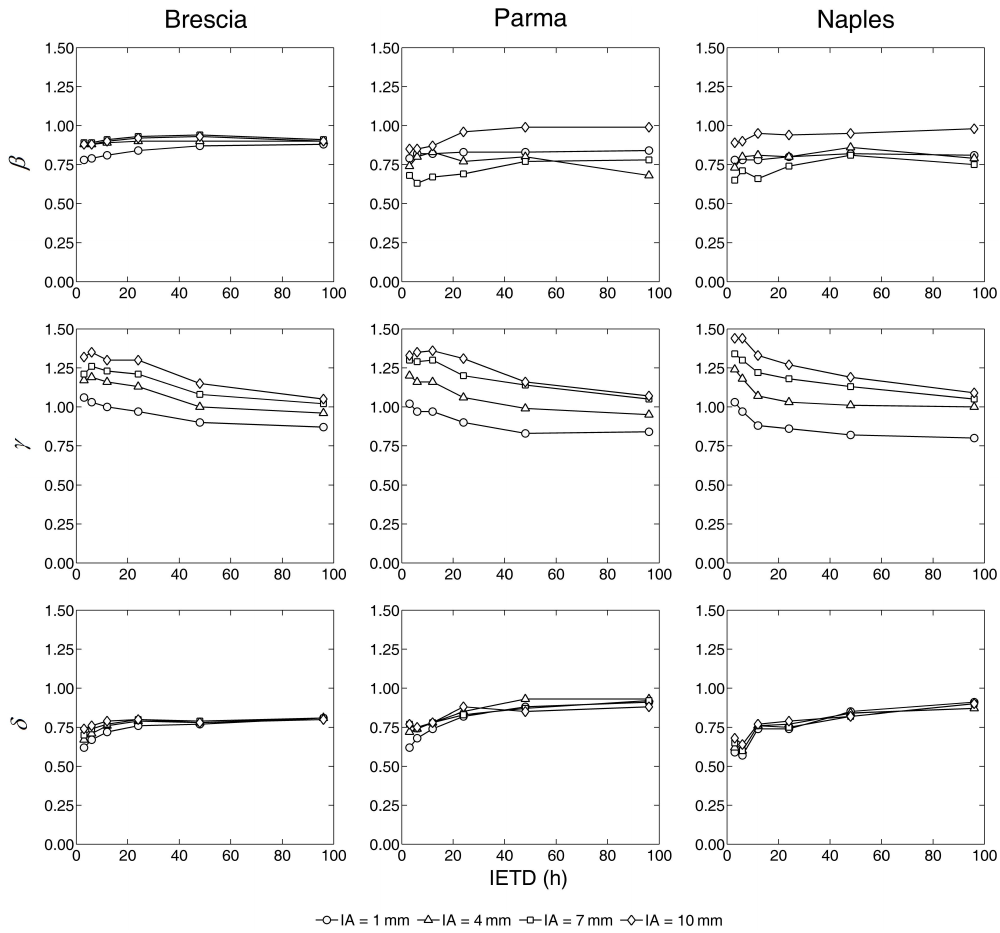
Fig. 4. Trends of the margin shape parameters according to the discretization thresholds.